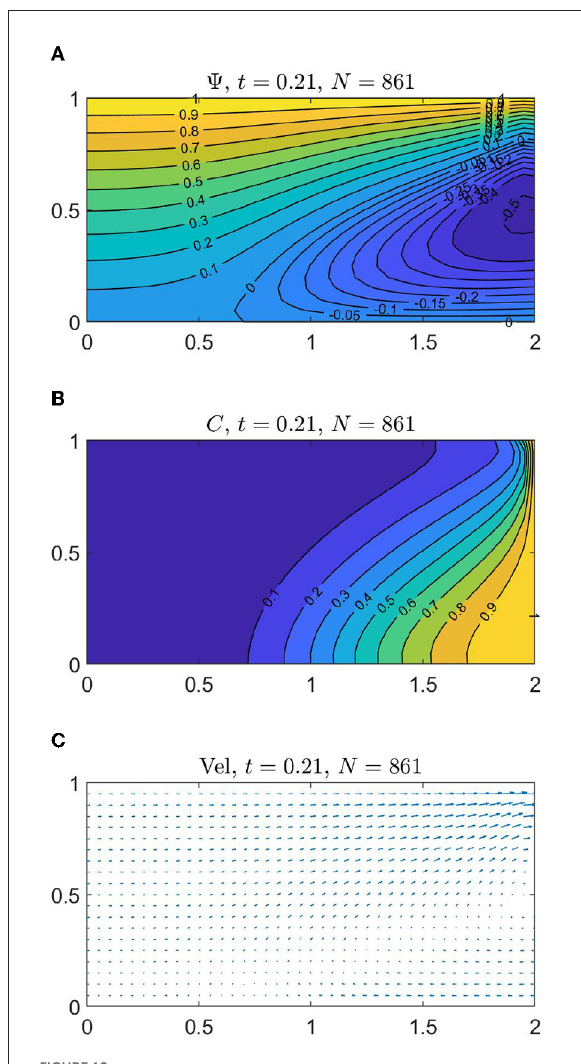
FIGURE12 Modified Henry problem ( a = 0.1315, b = 0.2). (A) Steady-state streamlines distribution. (B) Concentration distribution. (C) Velocity vector field.